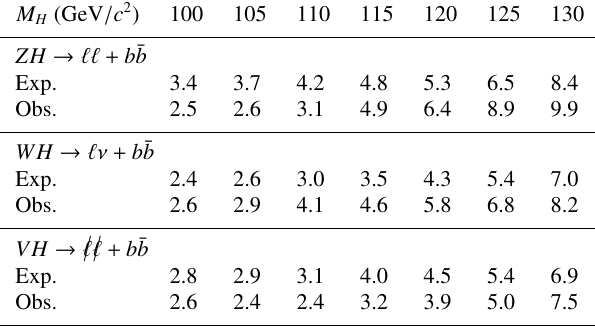
Table 2. Observed and expected 95% C.L. measured by the D0 experiment using a luminosity up to 8 . 5 fb − 1 for di ff erent SM Higgs boson masses in the primary search channels ( (cid:96)(cid:96) + b ¯ b , (cid:96) (cid:3) (cid:96) + b ¯ b , (cid:3) (cid:96) (cid:3) (cid:96) + b ¯ b ).